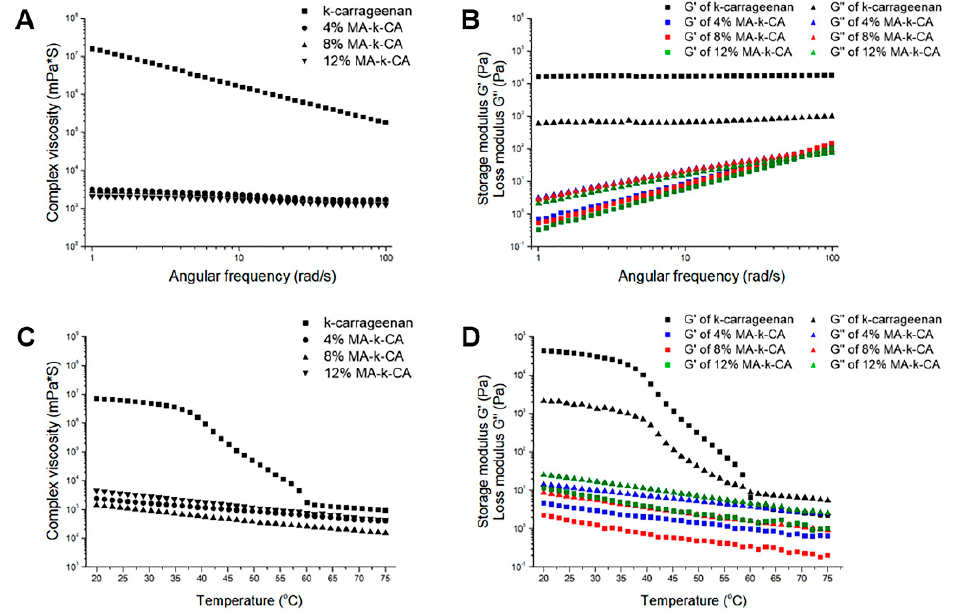
Figure 2. Angular frequency and temperature dependent rheological properties. Rheological properties of the κ -CA and MA- κ -CA (4, 8 and 12%) prepolymer solution at printing temperature (25 °C). ( A ) Complex viscosity ( B ) Storage modulus (G’) and Loss modulus (G”). Temperature dependent rheological properties of the κ -CA and 4, 8 and 12% MA- κ -CA prepolymer. ( C ) Complex viscosity ( D ) Storage modulus (G’) and loss modulus (G”).